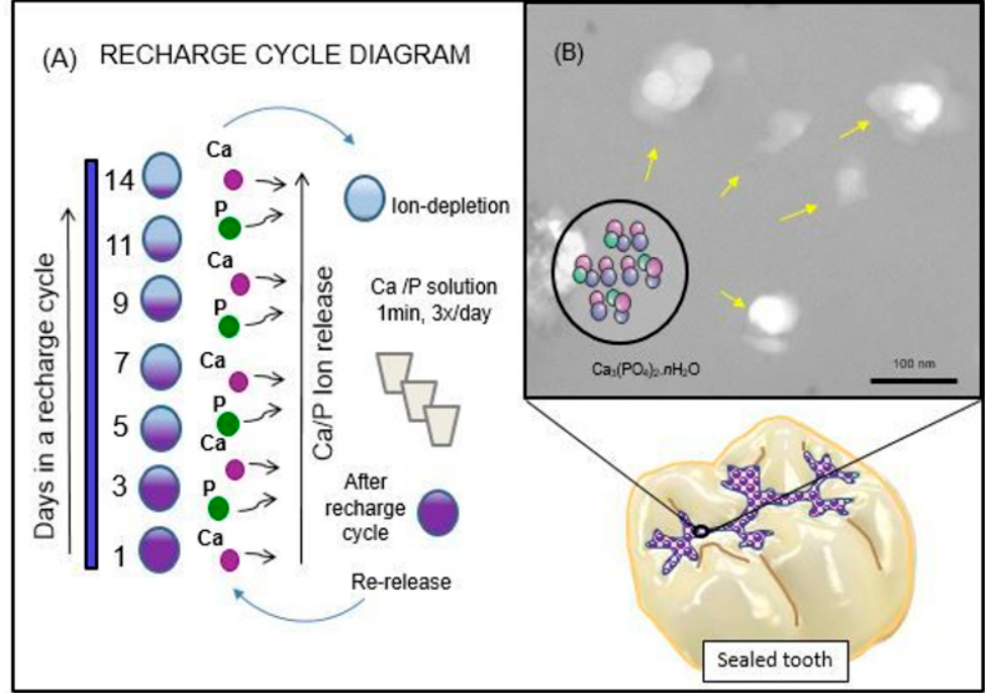
Figure 1. Schematic diagram of the rechargeable nanoparticles of amorphous calcium phosphate (NACP) sealant approach to deal with enamel demineralization around dental sealants: In ( A ), the recharge cycle diagram illustrates the re ‐ release from the exhausted and recharged NACP sealants. Three recharge/re ‐ release cycles were performed, and each re ‐ release was measured for 14 days. The ion re ‐ release increased with increasing the NACP filler level. In ( B ), the TEM image of NACP from the spray ‐ drying technique having sizes of about 100–300 nm.